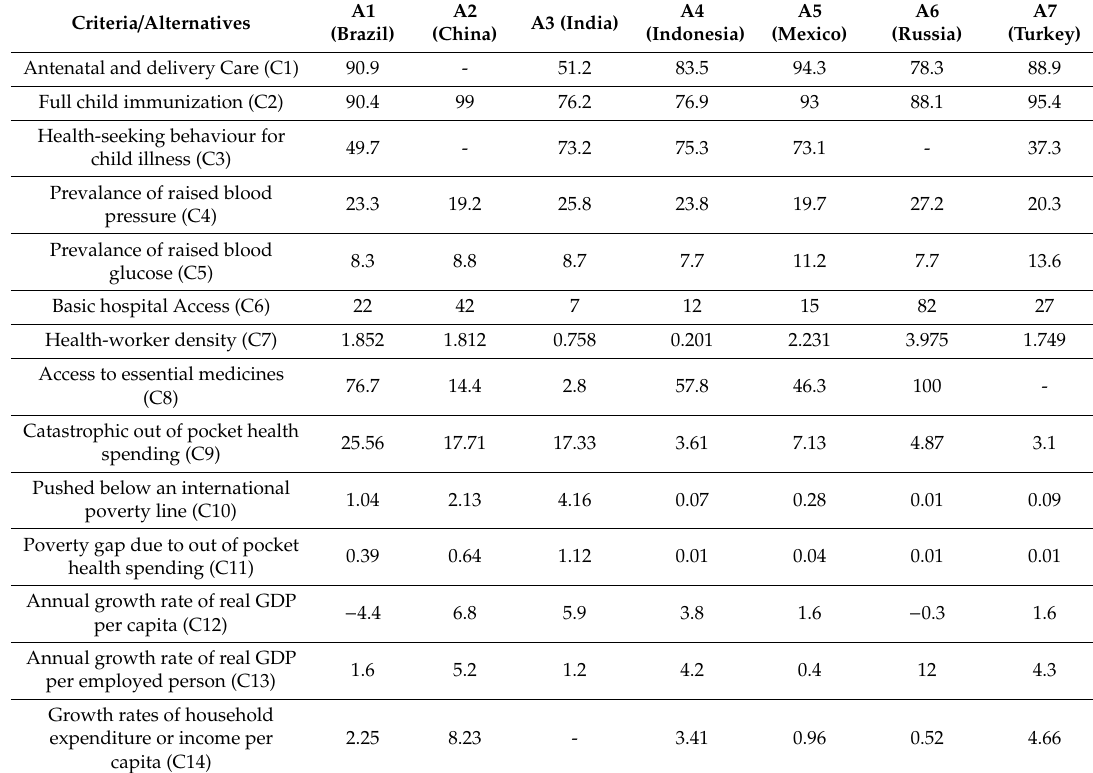
Table 10. Dataset of universal health coverage for the E7